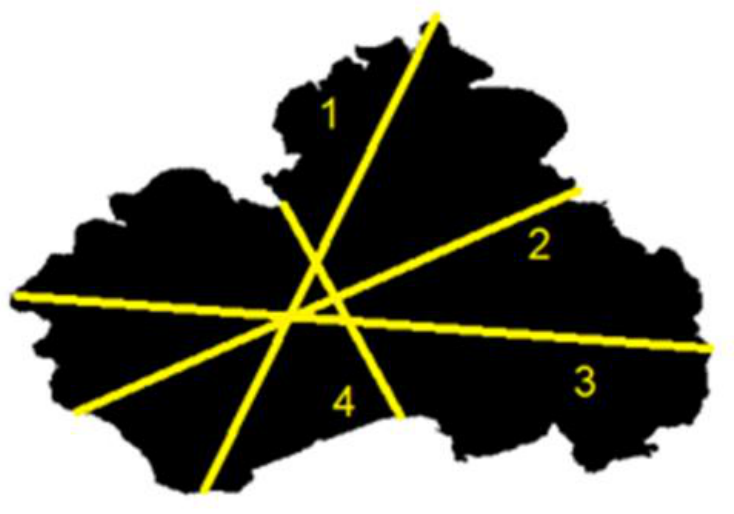
Figure 6. Four-position measurement scheme in areas with cavities or decay to calculate the average diameter.